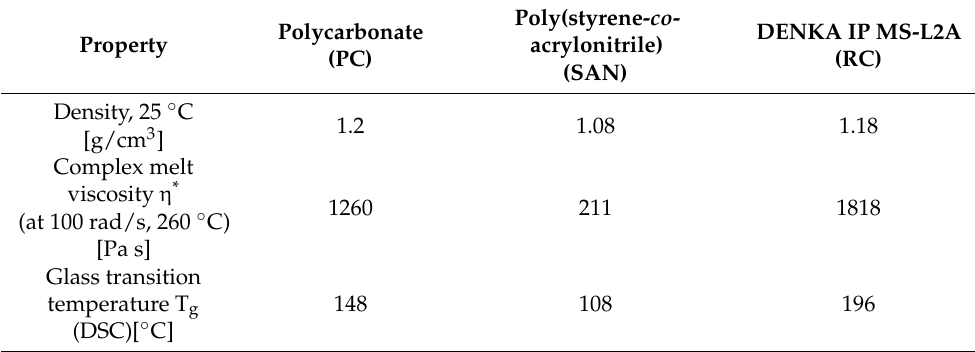
Table 3. Physical properties of the used polymers according to data sheets [58–60], melt viscosity measured by the authors (see Figure